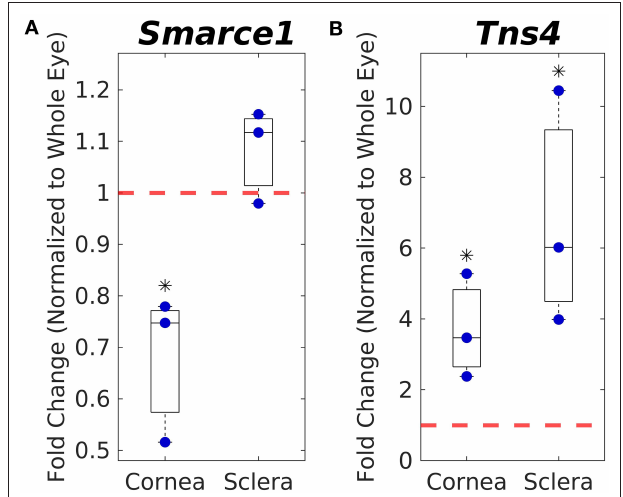
FIGURE 4 | Corneal and scleral mRNA expression levels of Smarce1 (A) and Tns4 (B) normalized to whole eye expression levels (indicated by dashed red line), as measured by PCR. Asterisks indicate significant difference from whole eye expression